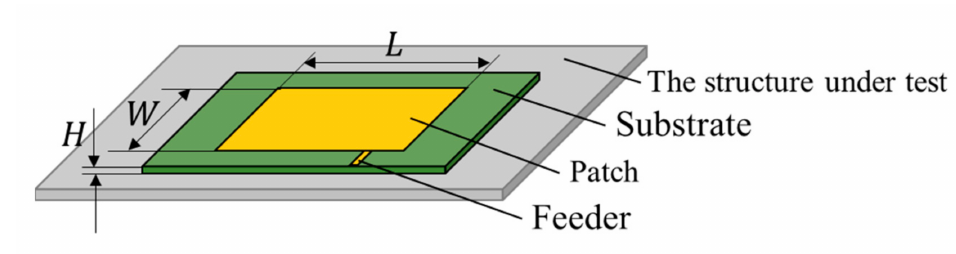
Figure 1. Basic patch antenna sensor